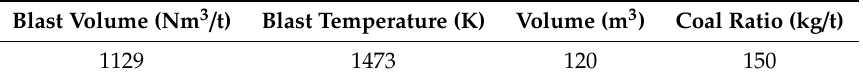
Table 1. Main blast parameters of TBF.